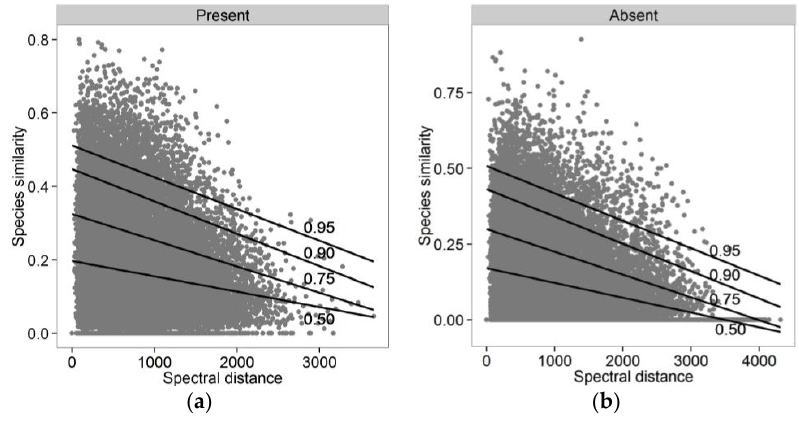
Figure 7. Quantile regression at 0.95, 0.90, 0.75 and 0.50 quantile in villages ( a ) with and ( b ) without forest institutions, plotting species dissimilarity against spectral dissimilarity. Table 5. Quantile regression at 0.95, 0.90, 0.75 and 0.50 quantiles for villages with and without in forest institutions categories, plotting species dissimilarity against spectral dissimilarity.